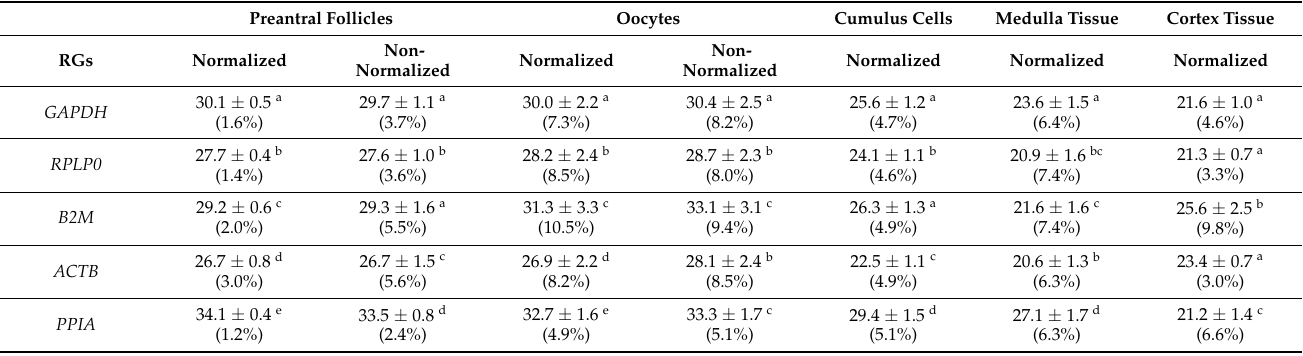
Table 1. Mean Ct values ± SD (% deviation) of the studied reference genes in each of the different samples from human